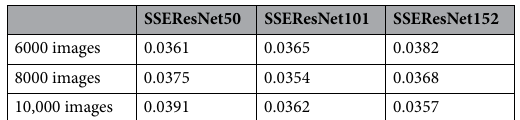
Table 3. Experimental results of different SSEResNet on different datasets.